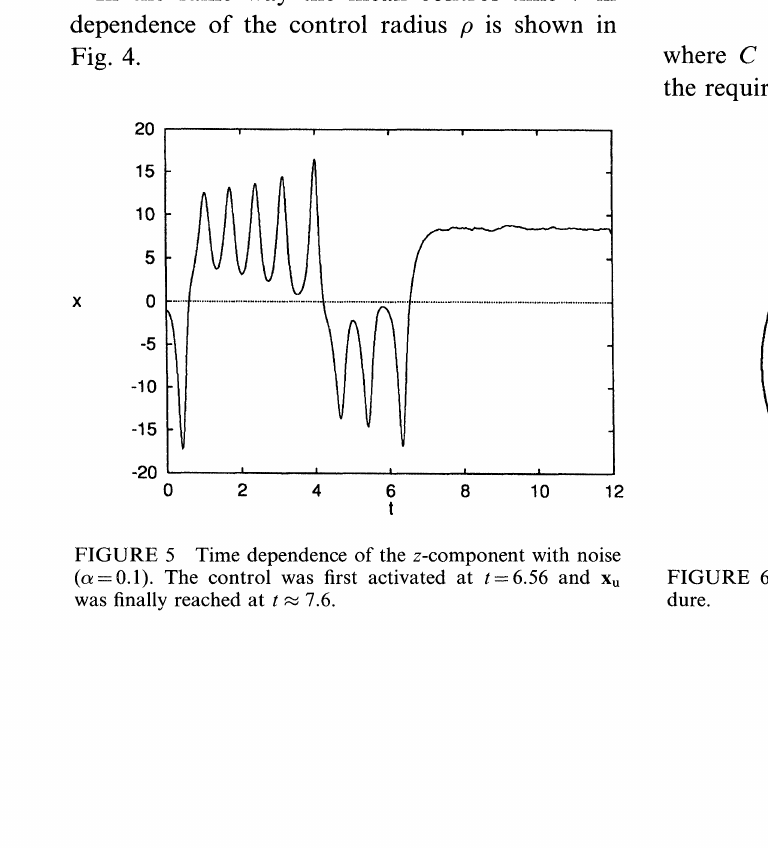
FIGURE 6 The effect of noise on the stabilization proce-